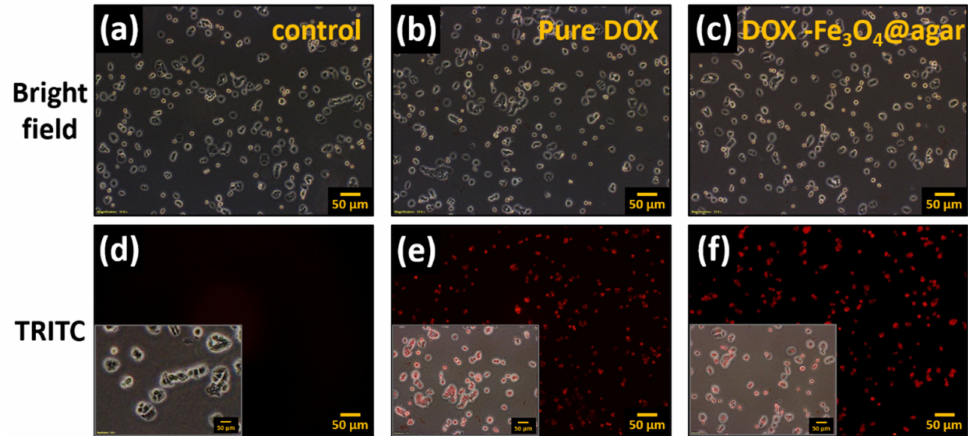
Figure 4. Fluorescence microscopy images of HT-29 cells after 1 h of incubation with pure DOX and DOX-Fe 3 O 4 @agar (on tetramethylrhodamine (TRITC) channel, at original magnification 100-fold); ( a , d ) control HT-29 cells, ( b , e ) pure DOX-treated cells, and ( c , f ) DOX-Fe 3 O 4 @agar-treated cells. Insert: Merged images of HT29 cells from bright and TRITC